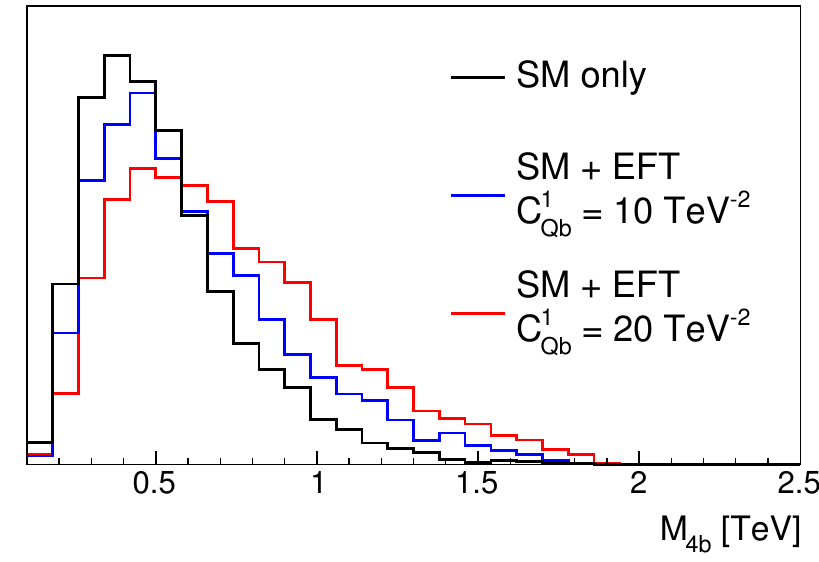
Figure 6 . Invariant mass of the four leading jets in the event ( M 4 b ) with and without the presence of EFT operators and before cutting on the maximal mass scale M cut .